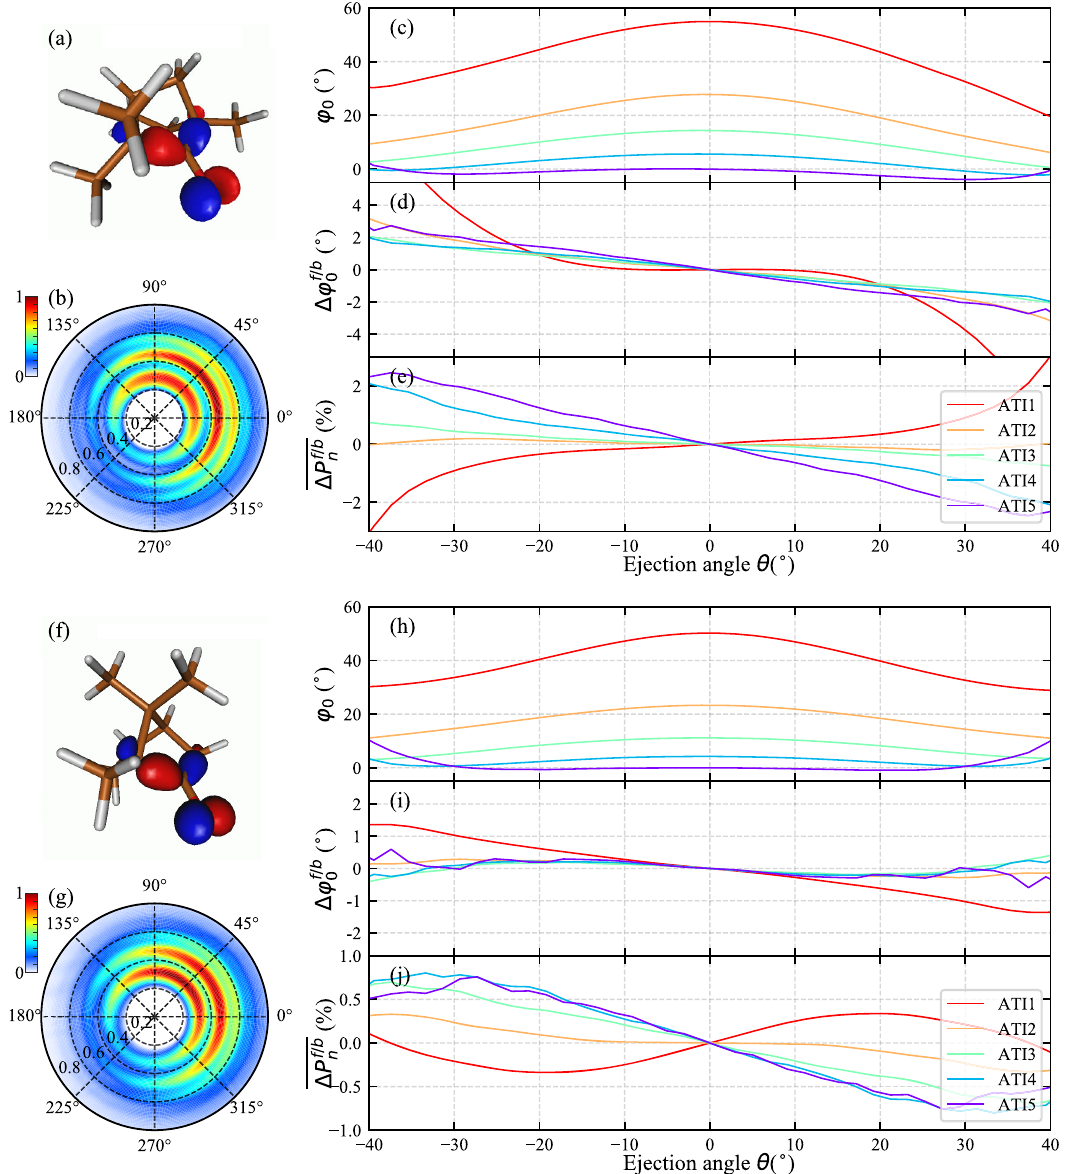
FIG. 2. Chiral attoclock measurements in ( þ )-fenchone and ( þ )-camphor, using an 800- and 400-nm bicircular field with I ω ≈ 4 × 10 13 W · cm − 2 and r ≈ 0 . 1 . (a) Molecular structure and highest occupied molecular orbital of fenchone obtained by means of Hartree-Fock calculations. (b) Photoelectron angular distribution from fenchone in the laser polarization plane ( θ ¼ 0 ). The radius is the photoelectron momentum in a.u. (c) Attoclock streaking angle φ 0 ;n for ATI peaks n ¼ 1 – 5 (from red to purple) as a function of the electron ejection angle θ . For each ATI peak n , we display in (d) the forward-backward asymmetry in the attoclock streaking angle Δ φ f=b 0 ;n ð θ Þ and in (e) the forward-backward asymmetry in electron yield Δ P f=b n ð θ Þ . (f) – (j) are identical to (a) – (e) but relative to ( þ